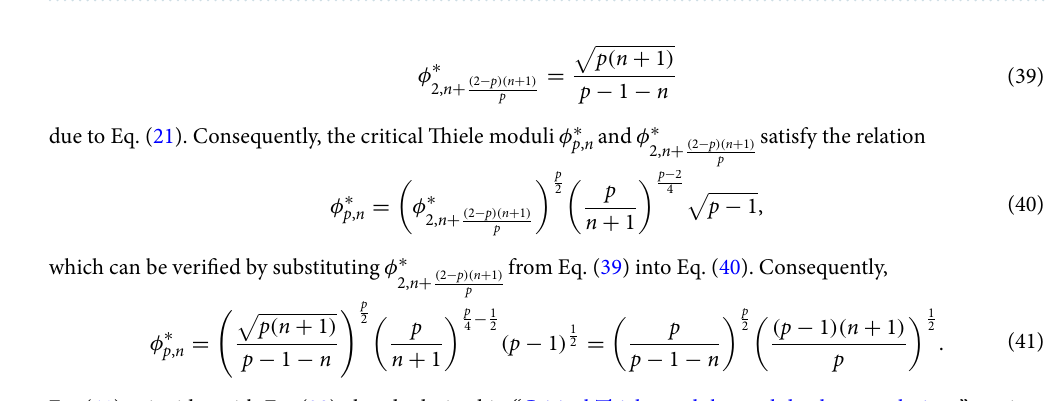
Figure 2. Dependence of critical Thiele modulus φ ∗ p , n on ( a ) diffusion exponent p and ( b ) reaction order n